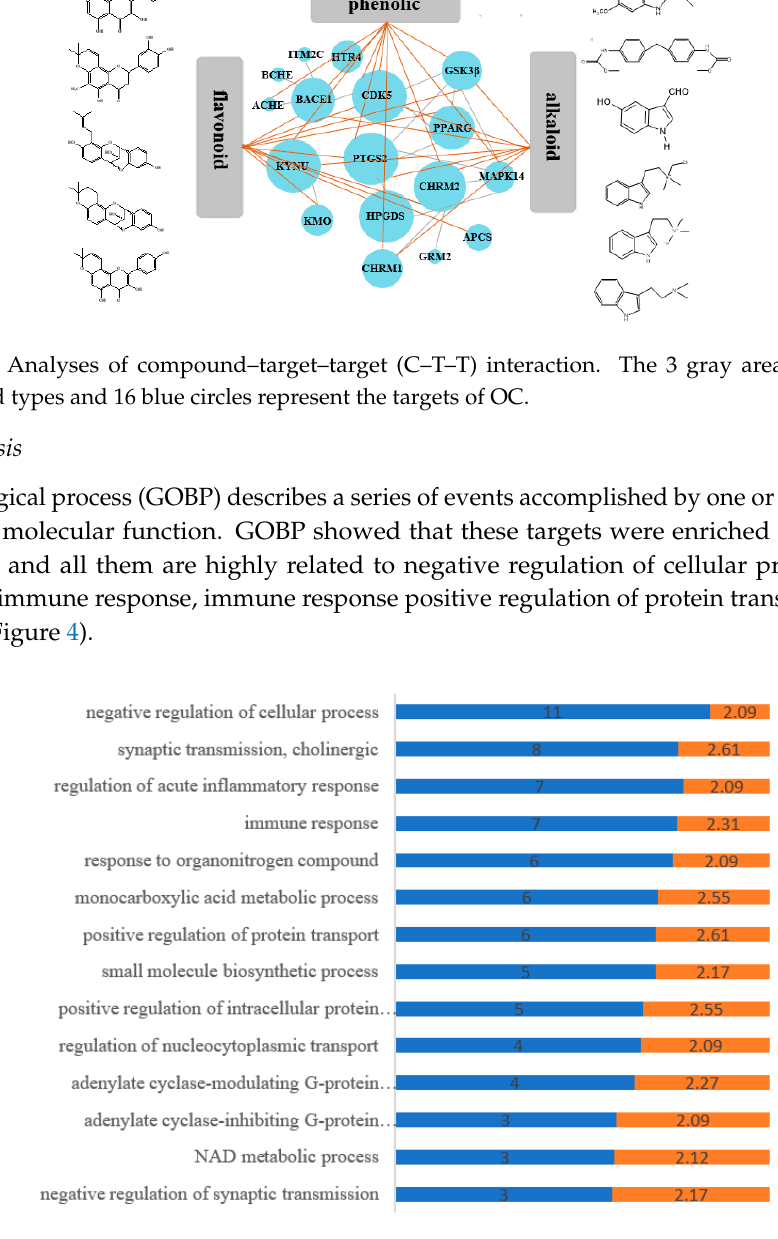
Figure 4. Gene Ontology (GO) biological process (GOBP) analysis. Counts of genes (blue) and − log10 p -value (orange) related to each biological process from DAVID 6.8